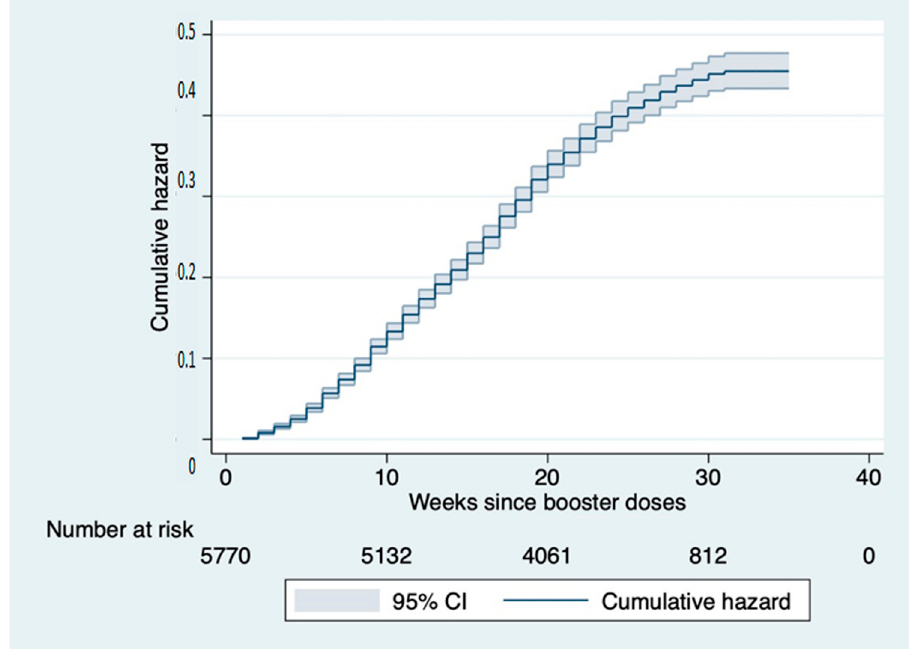
Figure 2. Nelson–Aalen cumulative hazard estimates: curve representing the cumulative risk of infection after booster dose in the study cohort over the follow-up period. Stratifying by sex, males show a cumulative risk of 15% at 12 weeks and 36% at 24 weeks. In females, this is higher at the respective weeks with values of 19% and 42%. The difference between the two curves in the log-rank test appears statistically significant ( p < 0.001) (Figure 3).